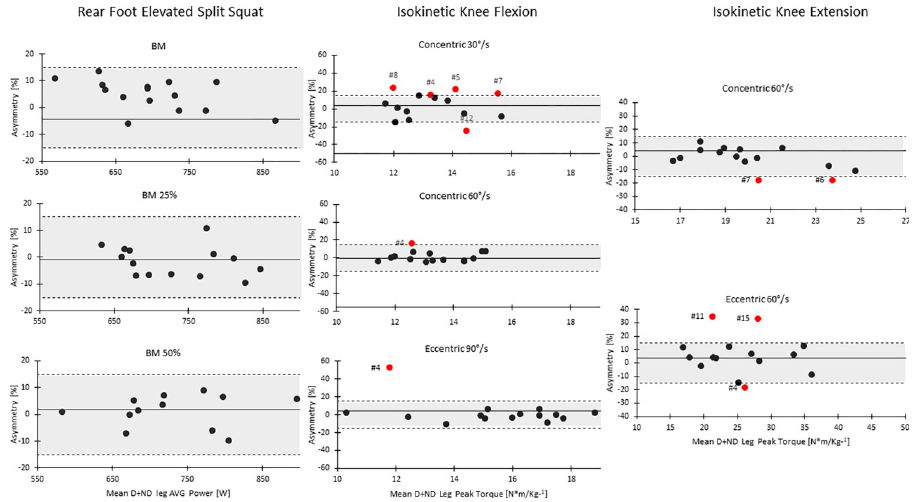
Fig 4. Mean power, mean force, magnitude and direction of inter-limb asymmetry in Rear Foot Elevated Split Squat, isokinetic flexion and isokinetic extension assessments. Empty circles represent players with asymmetry > 15%. BM = Body mass, BM25% = Body mass 25%, BM50% = Body Mass 50%, DL = Dominant Leg, NDL = Non-dominant leg, AVG Power = Average